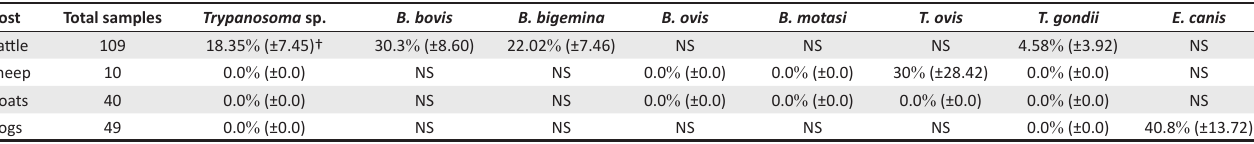
TABLE 2: Overall infection rate of protozoan parasites and Ehrlichia from different hosts. Host Total samples Trypanosoma sp.